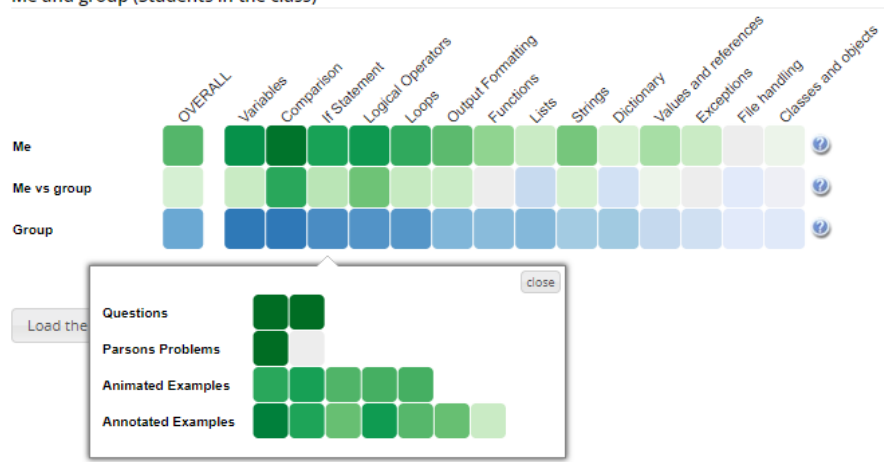
Figure 3. Mastery Grids interface showing student progress at the topic level and the available smart learning contents for the If Statement topic. Student’s progress for each content type is shown in the pop-up